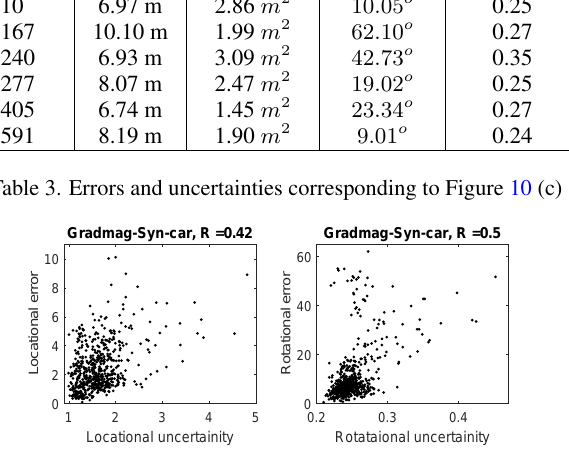
Figure 11. (a) Location uncertainty vs error (b) Rotational uncertainty vs errors for Gradmag-Syn-car